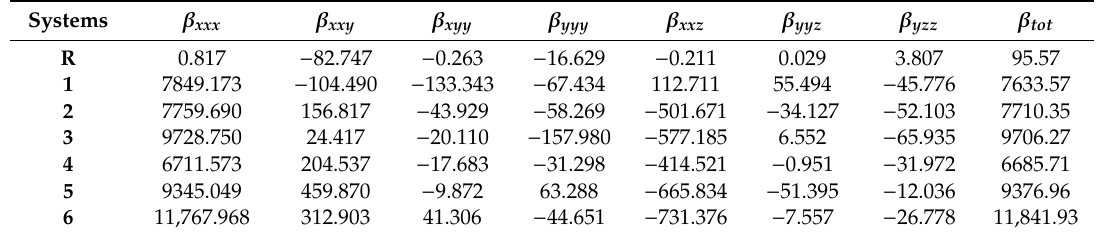
Table 6. The computed second-order polarizabilities ( β tot ) and major contributing tensors (a.u.) of R and 1 – 6 in the gas phase at the CAM-B3LYP / 6-31G(d,p) level of theory.